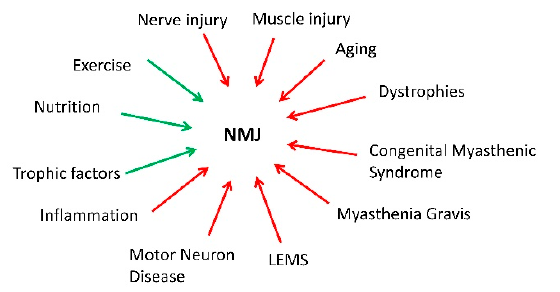
Figure 2. The neuromuscular junction (NMJ) as a central node in neuromuscular function. There are many conditions in which the NMJ plays a critical role or at least as a mediator of disease (red). However, some interventions can minimize NMJ dysfunction (green). LEMS: Lambert-Eaton Myasthenic Syndrome